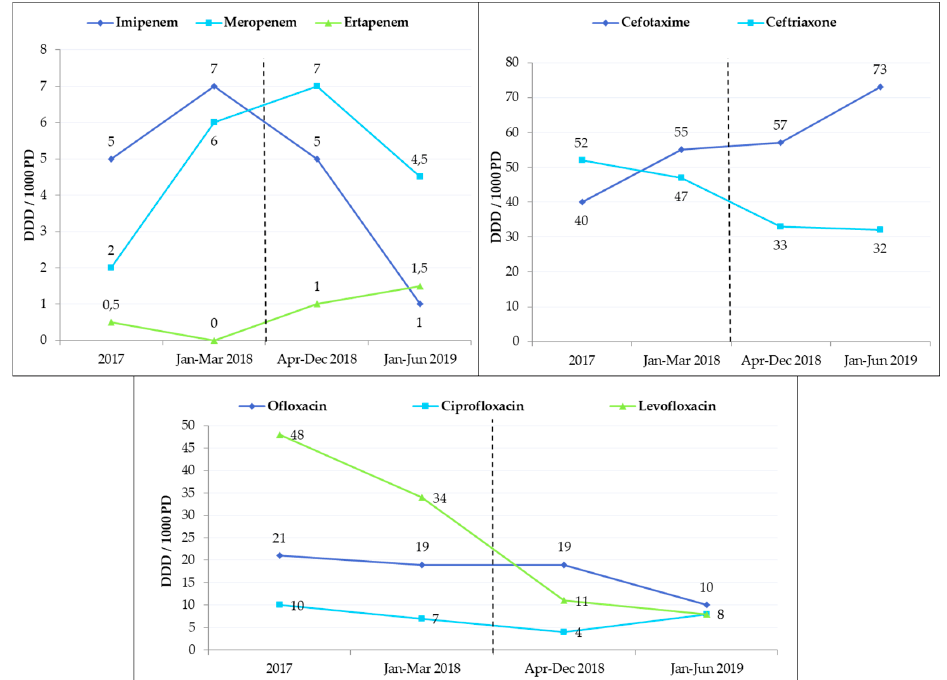
Figure 6. Evolution over time of antibiotic consumption in the eight units that tested the prospective audit and feedback intervention (antibiotics prescription review). Dotted lines represent initiation of critical antibiotics review in association with pharmacy unit members. Data are presented as defined daily dose of antibiotics per 1000 patient-days.